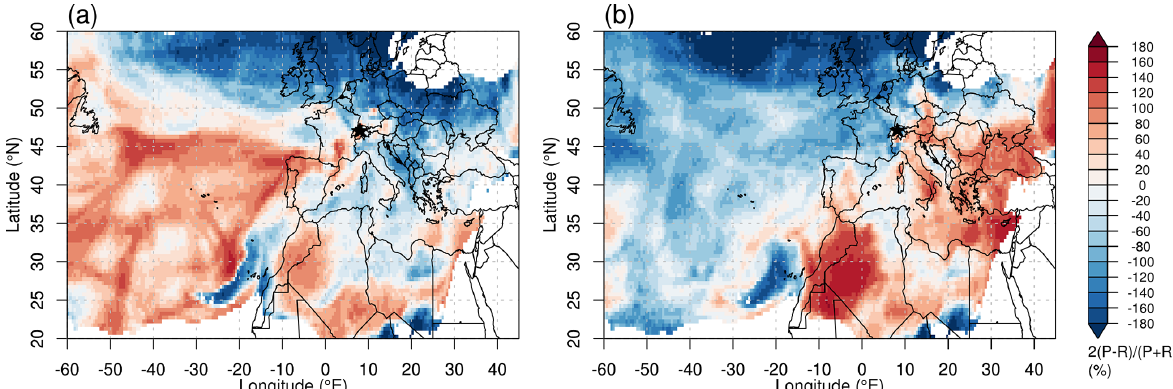
Figure 4. FLEXPART source emission sensitivities for particles released at JFJ (indicated by black star) every 3h and tracked backward in time, for time periods during this campaign with (a) elevated n s and (b) [INP], at − 31 ◦ and above water saturation. Elevated values are above median values from a multi-year and multi-season analysis for free tropospheric conditions at JFJ ( n s > 8 . 19 × 10 8 m − 2 and [INP] − 31 > 2 . 1stdL − 1 ; Lacher et al., 2018a). The color code indicates the relative surface residence time, from low (blue) to high (red). Table 1. Ranked correlation coefficients for [INP] − 31 and n s (both determined > LOD) with m/z values for the LAAPTOF (a) and AL- ABAMA (b) , for methods 1 and 2, respectively. The assignment of potential ions to m/z values can be found in the Supplement (Table